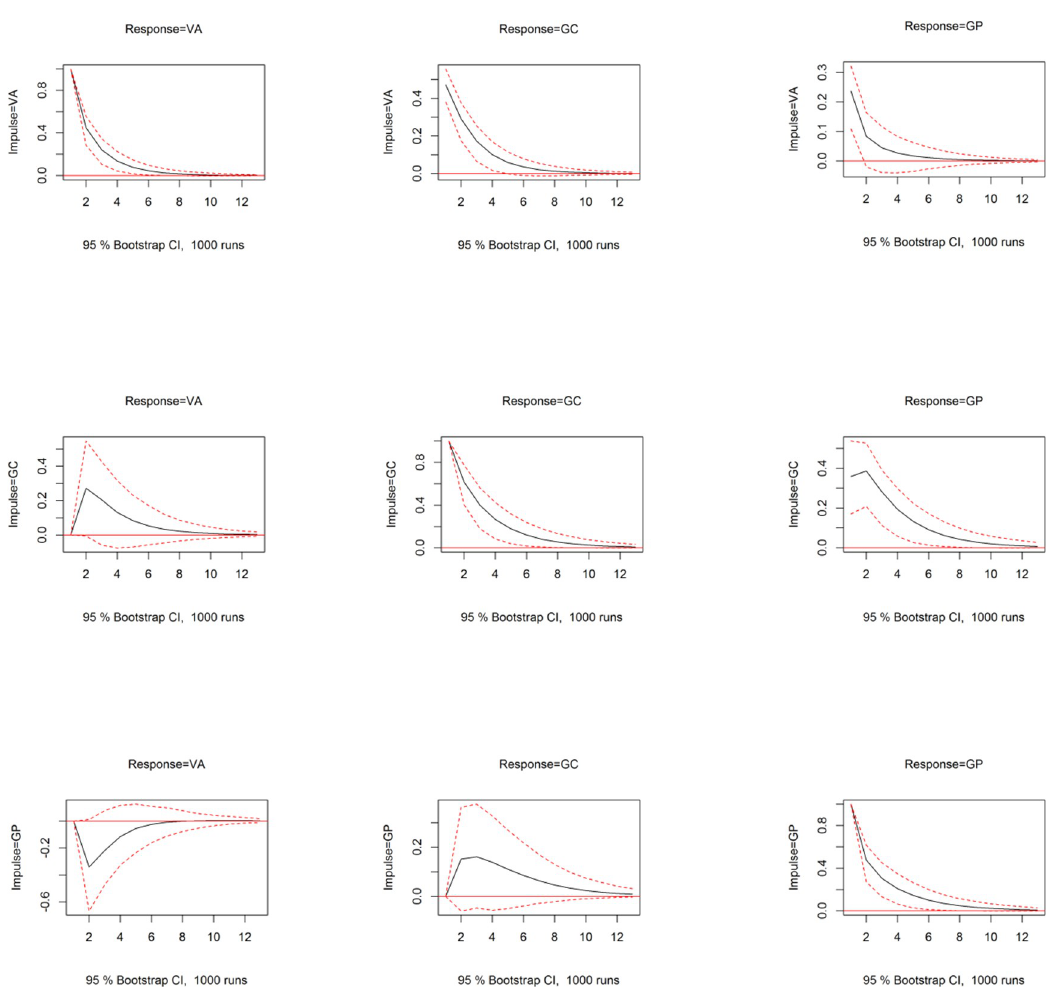
Fig 2. 12-month impulse-response functions (solid line), with corresponding 95% confidence intervals (dotted lines), representing the impact of one standard deviation moves in the impulse variable on the corresponding response variable.